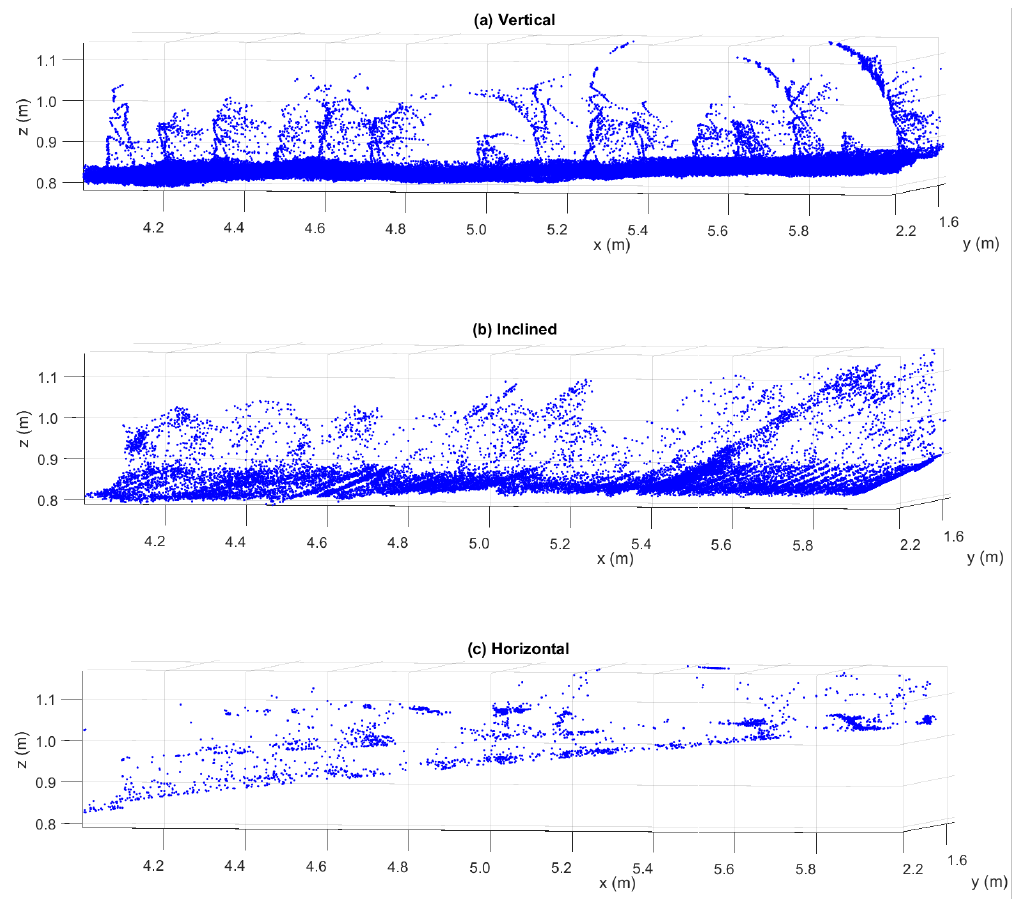
Figure 5. Raw data point cloud obtained with ( a ) vertical; ( b ) inclined; and ( c ) horizontal LiDAR orientation while “Talos” was moving in descending order in x-axis.